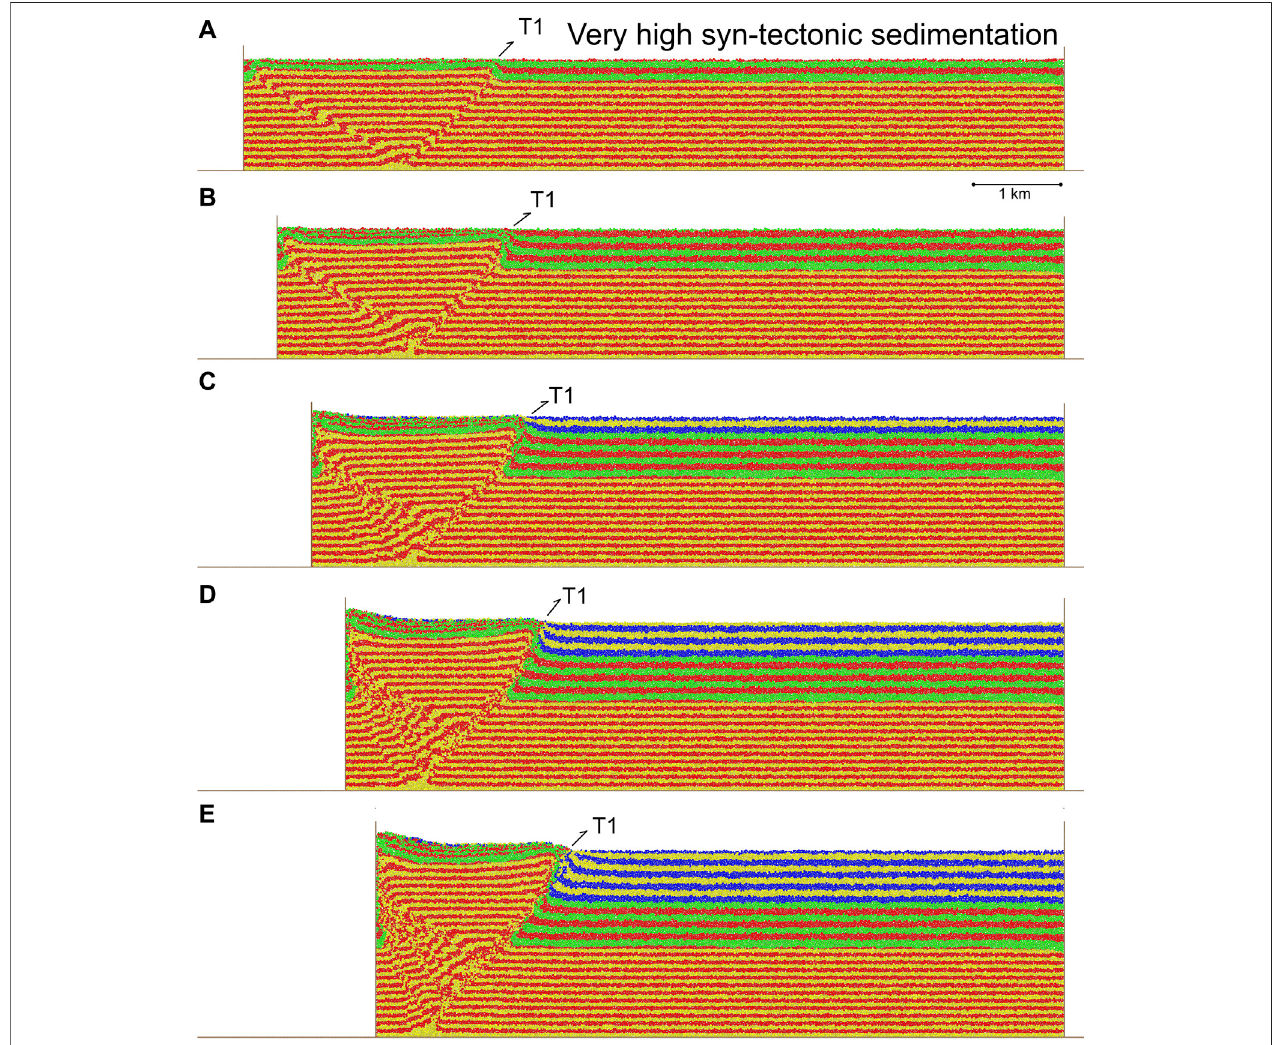
FIGURE 6 | Experiment 5, progressive evolution of a contractional model with “ very high ” syn-tectonic sedimentation. Results are shown after 500 (4%), 1,000 (8%),1,500(12%),2000(16%),and2,500(20%) mcontraction/displacementontheleft-handend-wall.Twodistinctgrowthpackagesarehighlighted/colouredinorder toshowthestratalarchitectures developedinearly(green-redpackage)andmid/late(blue-yellowpackage) faultarraygrowth,thetransitionoccurringatc.1,250(10%) m of lateral contraction, see text for discussion.